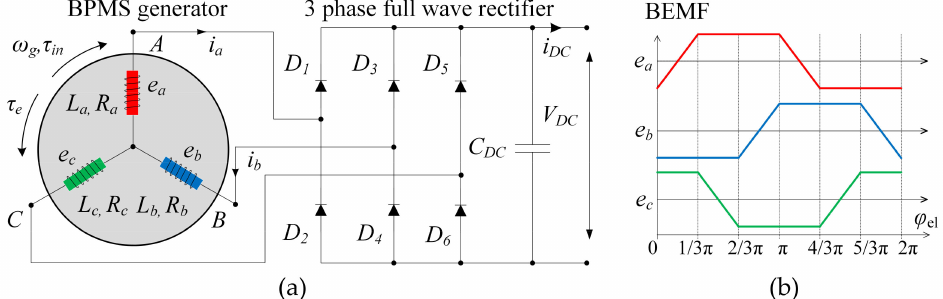
Figure 8. BMPS: ( a ) electrical circuit of the three-phase BPMS EG and its connection to the three-phase full-wave diode rectifier; ( b ) trapezoidal back-emf waveforms of individual EG